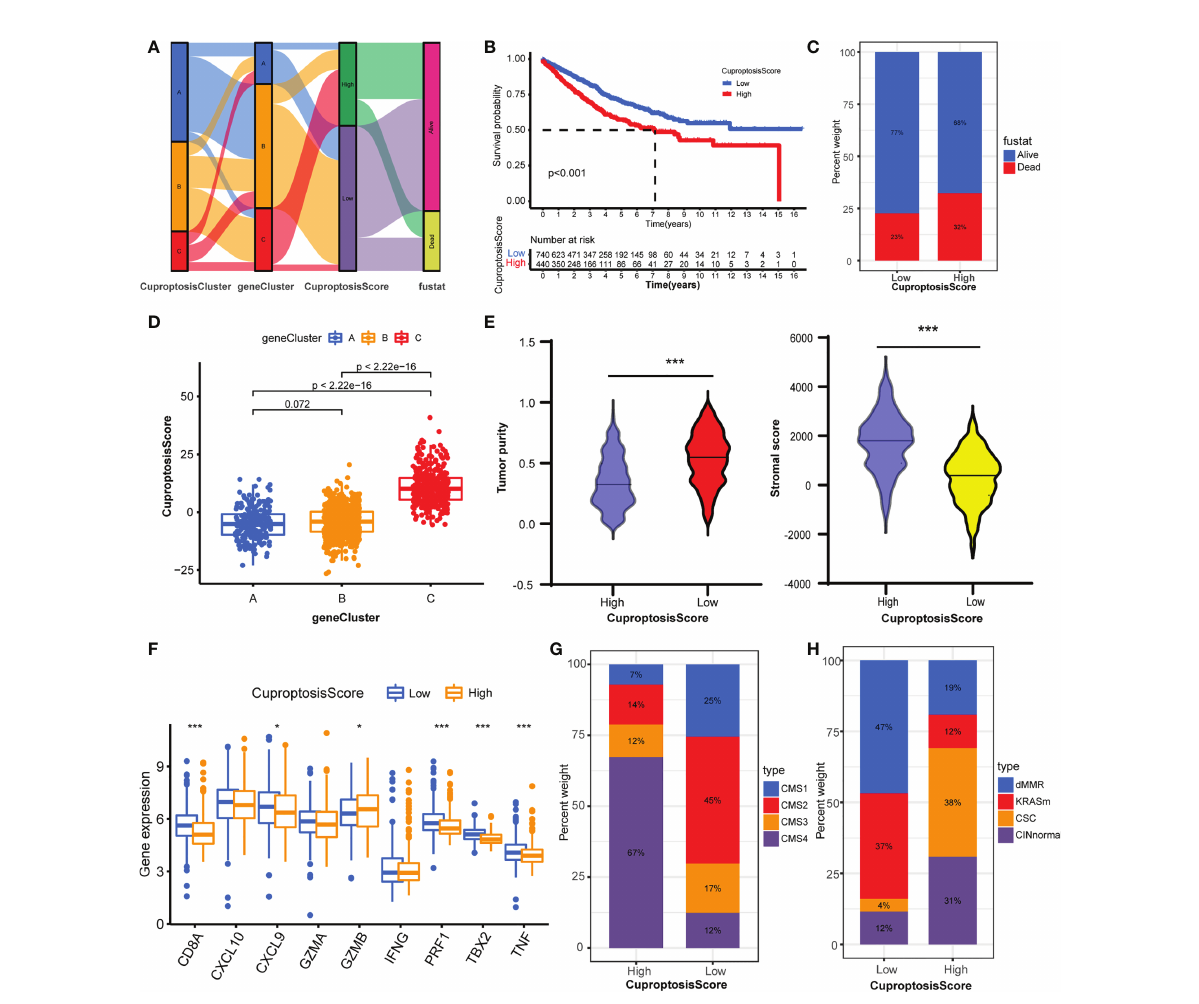
FIGURE 5 Construction of CuproptosisScore and their TME characteristics in colorectal cancer. (A) Alluvial diagram showing the attribute changes from CuproptosisClusters to gene Clusters to CuproptosisScore to survival status. (B) The Kaplan – Meier curves of overall survival between high and low CuproptosisScore group. (C) The frequencies of alive and dead status in high and low CuproptosisScore group. (D) The CuproptosisScores of the three geneClusters. (E) The stromal score and tumor purity in high and low CuproptosisScore group. (F) The expression levels of immune activity-related genes in high and low CuproptosisScore groups. (G) The CMS analysis of the two CuproptosisScore groups. (H) The molecular subtypes analysis of GSE39582 dataset in the two CuproptosisScore groups. *P <0.05; ***P